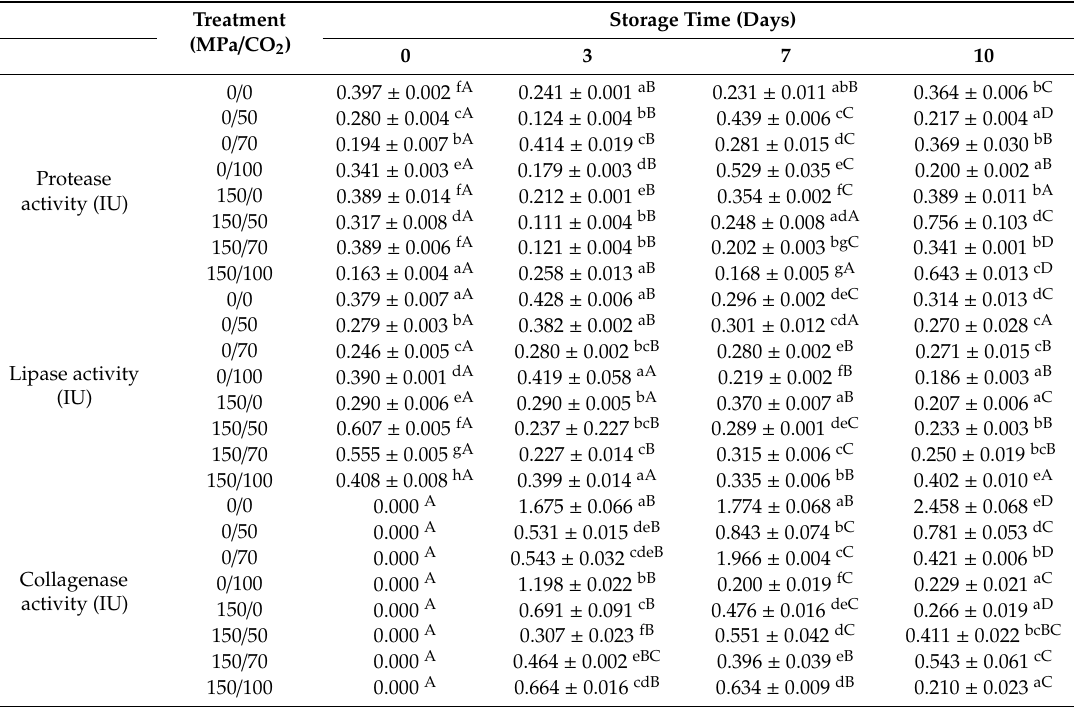
Table 1. E ff ect of treatment and refrigerated storage time on enzyme activity of coho salmon fillets.